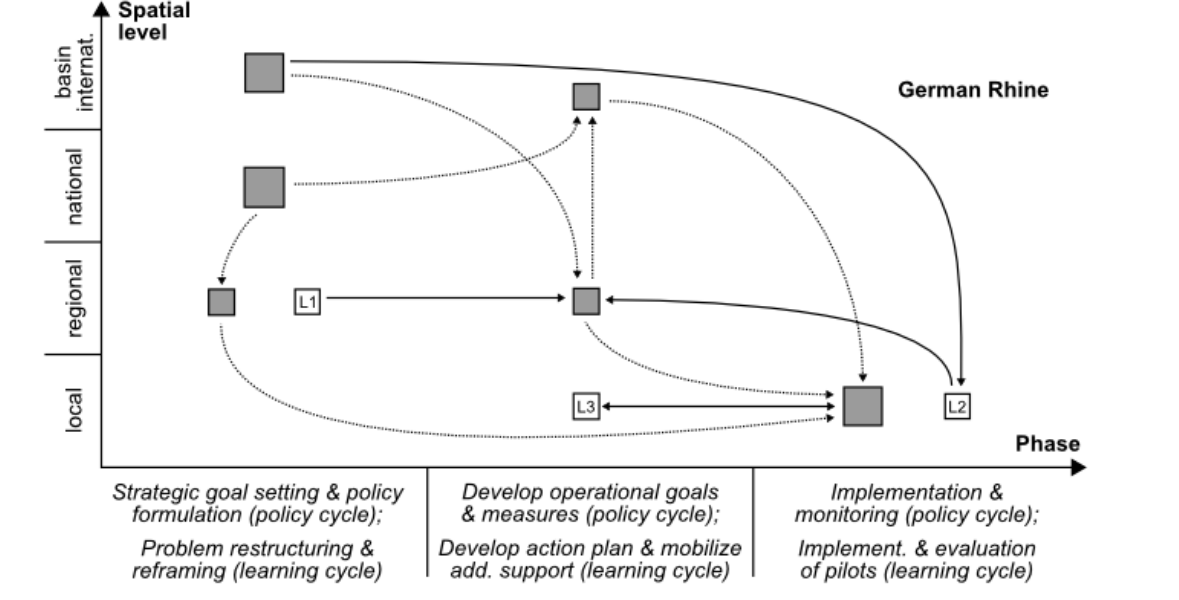
Fig. 5 . Formal policy and informal learning processes and their interdependencies in the German Rhine. See Figure 2 for detailed explanations of the notations and Figure A3 in Appendix 2 for the nonaggregated